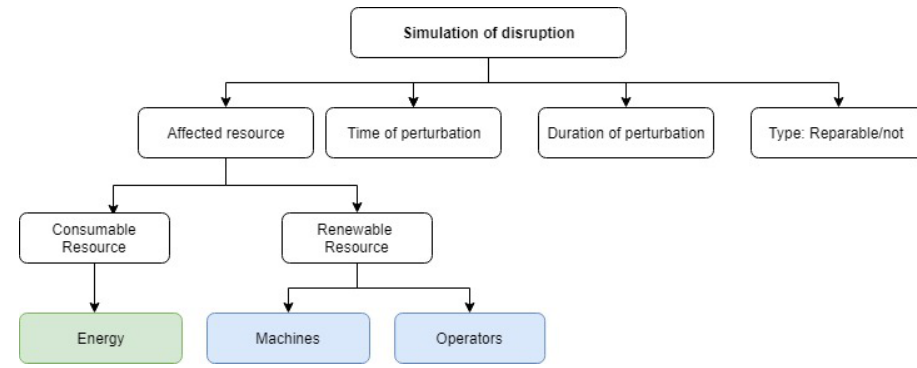
Figure 5. Simulation of